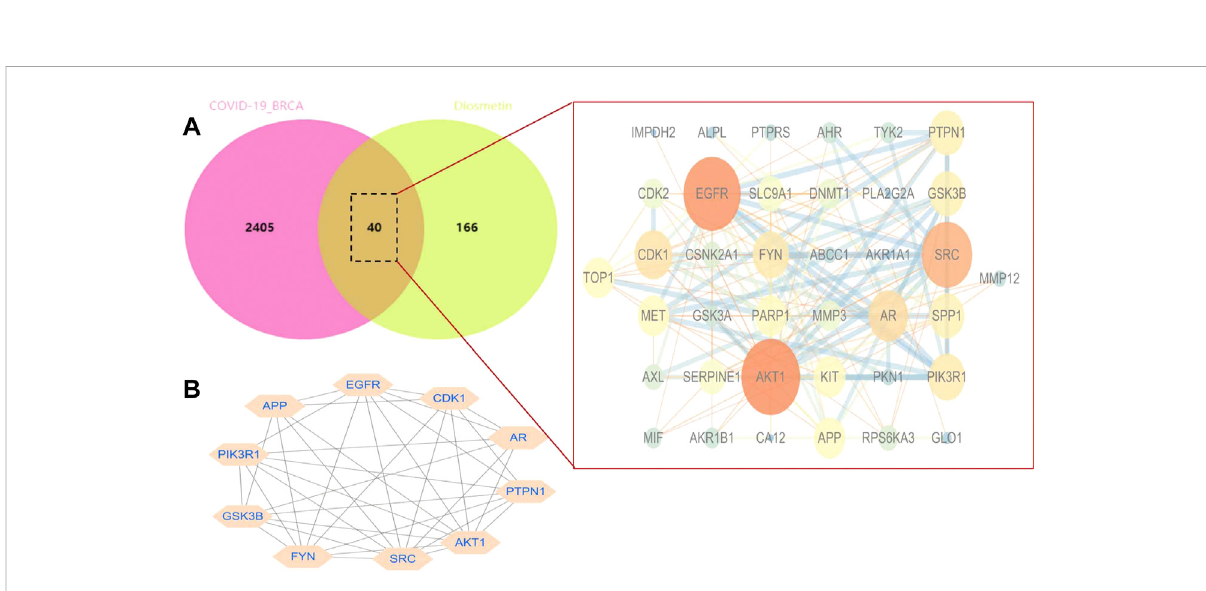
FIGURE 8 Network analysis of Diosmetin anti-BRCA/COVID-19 genes. (A) STRING analysis of the protein – protein interaction network mediated by 40 Diosmetin cross-targets. (B) Cellular landscape analysis representing the protein interaction network associated with Diosmetin anti-COVID-19/ BRCA effects. The 10 core targets (EGFR, PIK3R1, SRC, AKT1, AR, FYN, PTPN1, APP, CDK1, and GSK3B) are